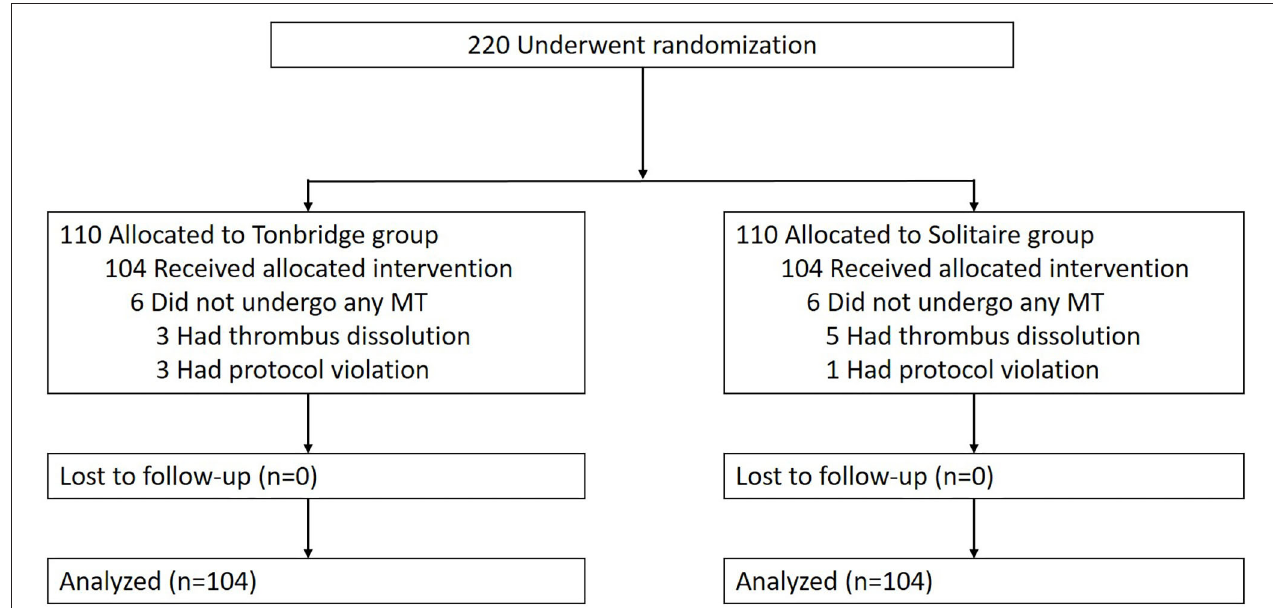
FIGURE 2 | Randomization and treatment of the patients.